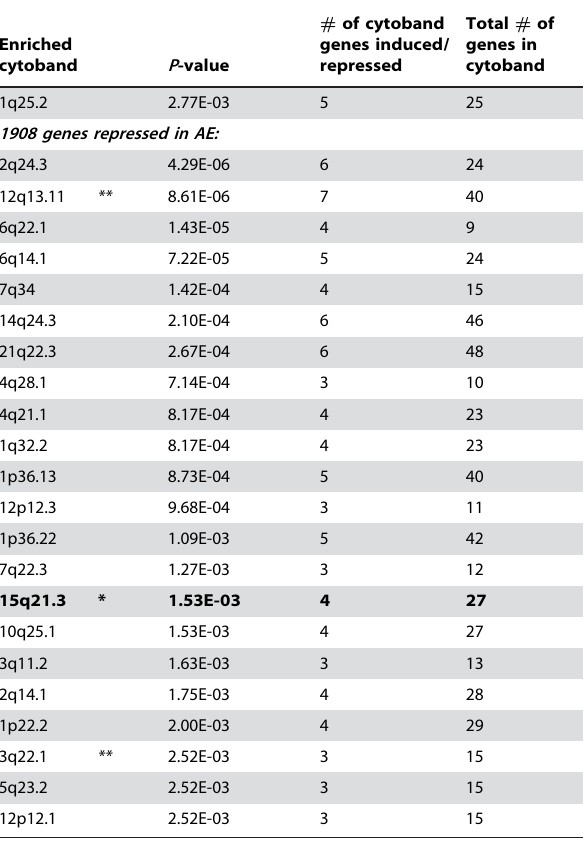
Shown are chromosomal regions (cytobands) that are enriched in 2194 genes induced or 1908 genes repressed in AE (P , 0.05; FDR , 0.05). Cytobands are sorted by P-value. Overlap with previously known AE genome-wide scan regions [5–8,37], AE candidate gene regions [2,36,39–40], and AE regions identified by selective region specific linkage mapping [35,38] are indicated in the second column by *, **, and ***,